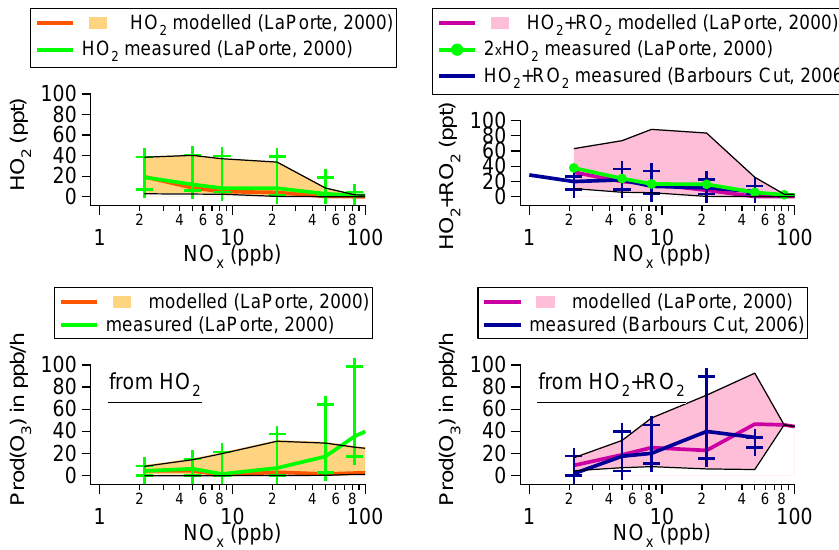
Fig. 11. Comparison of modelled (with the TexAQS 2000 model) and measured HO 2 , HO 2 + ΣRO 2 and Prod( O 3 ) in LaPorte (2000) and Barbours Cut (2006). The shaded areas and the bars indicate the 10-th and 90-th percentiles.